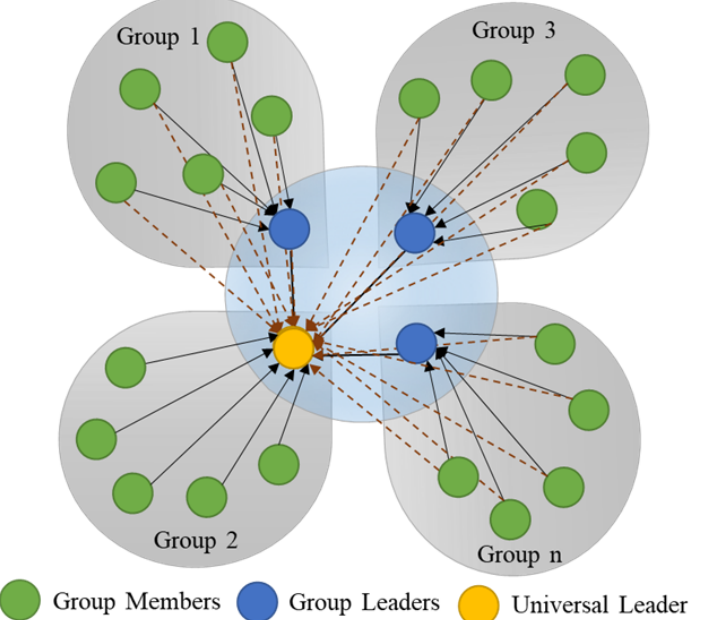
Figure 2. Organization of swarm in Graded Swarm Particle Swarm Optimizer. The swarm is divided into groups, and each group has a group leader. All the group leaders form a hierarchical group with a universal leader. All the particles/members in the group are influenced by the personal best, the group best, and the universal best